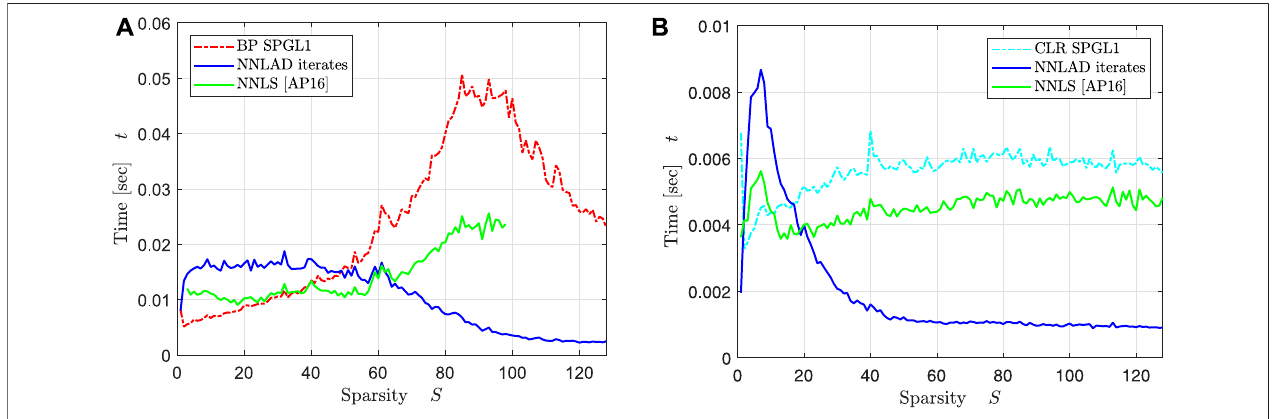
FIGURE10| TimeoftheNNLADandNNLStoapproximatebetterthanSPGLmethods. (A) TheNNLADisfasterthantheBPofSPGL1forhigh S . (B) .TheNNLAD is faster than the CLR of SPGL1 for moderate